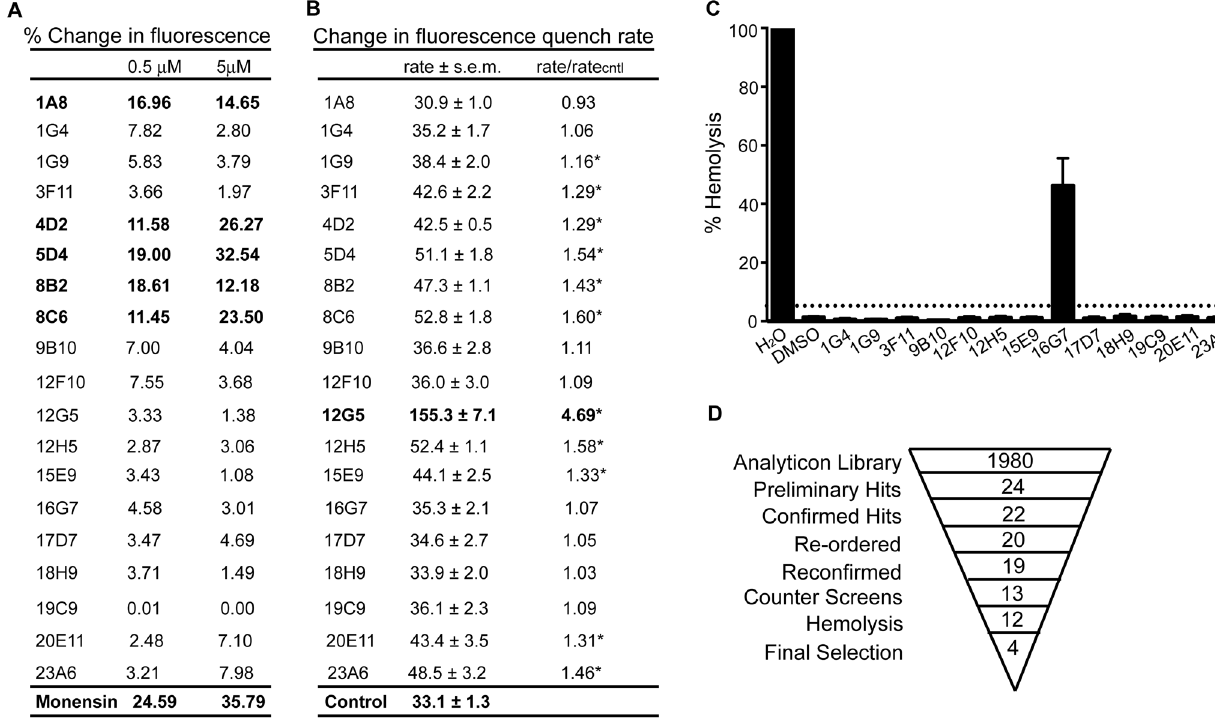
Figure 2. Secondary screens and summary of HTS results. (A) Liposome assay: large unilamellar vesicles were loaded with fluorescein-5-(and- 6-)-sulfonic acid, trisodium salt at pH 7.4 and exposed to pH 6.4 with or without compound. Fluorescence was measured over a 5 second time course, and numbers are adjusted for DMSO control. (B) Gramicidin channel assay: ANTS-loaded large unilamellar vesicles were mixed with quenching buffer and compound (10 m M) and the rate of fluorescence quenching was measured. n= 7–8 for each compound and 33 for control (DMSO only). *denotes that the p value relative to control is less than 0.001. (C) Human red blood cells were exposed to compound for 1 hour and absorbance was read in a spectrophotometer at 560 nm to evaluate heme release. Dotted black line represents 5% lysis cutoff. Results show means 6 SEM of two independent experiments, each performed in duplicate. (D) Summary of screening results.